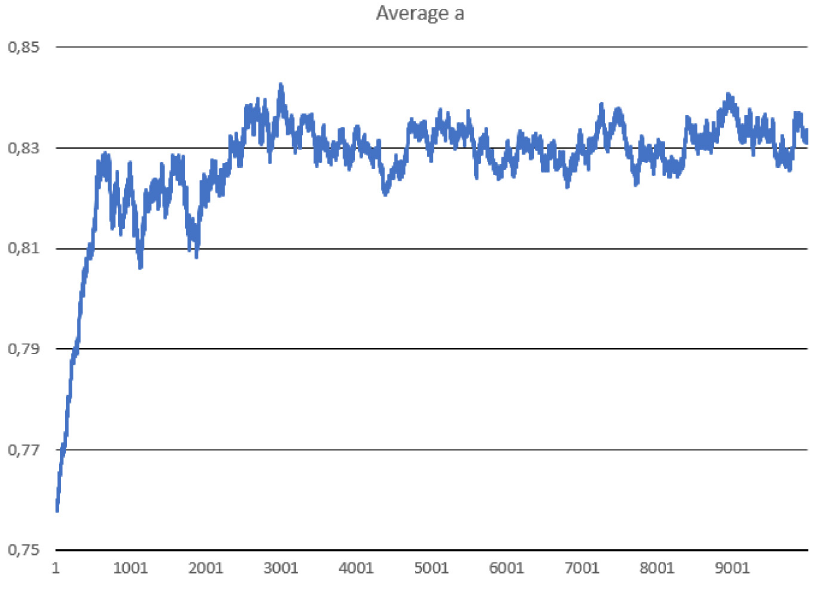
Fig 6. The average replication efficiency of replicases in Scenario